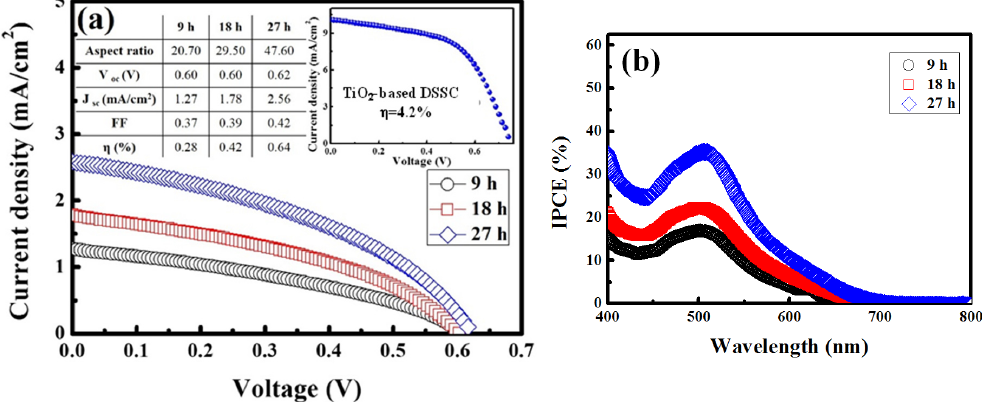
Figure 5. ( a ) J ‐ V measurements under AM 1.5 illumination (100 mA ∙ cm − 2 ) and ( b ) IPCE spectra